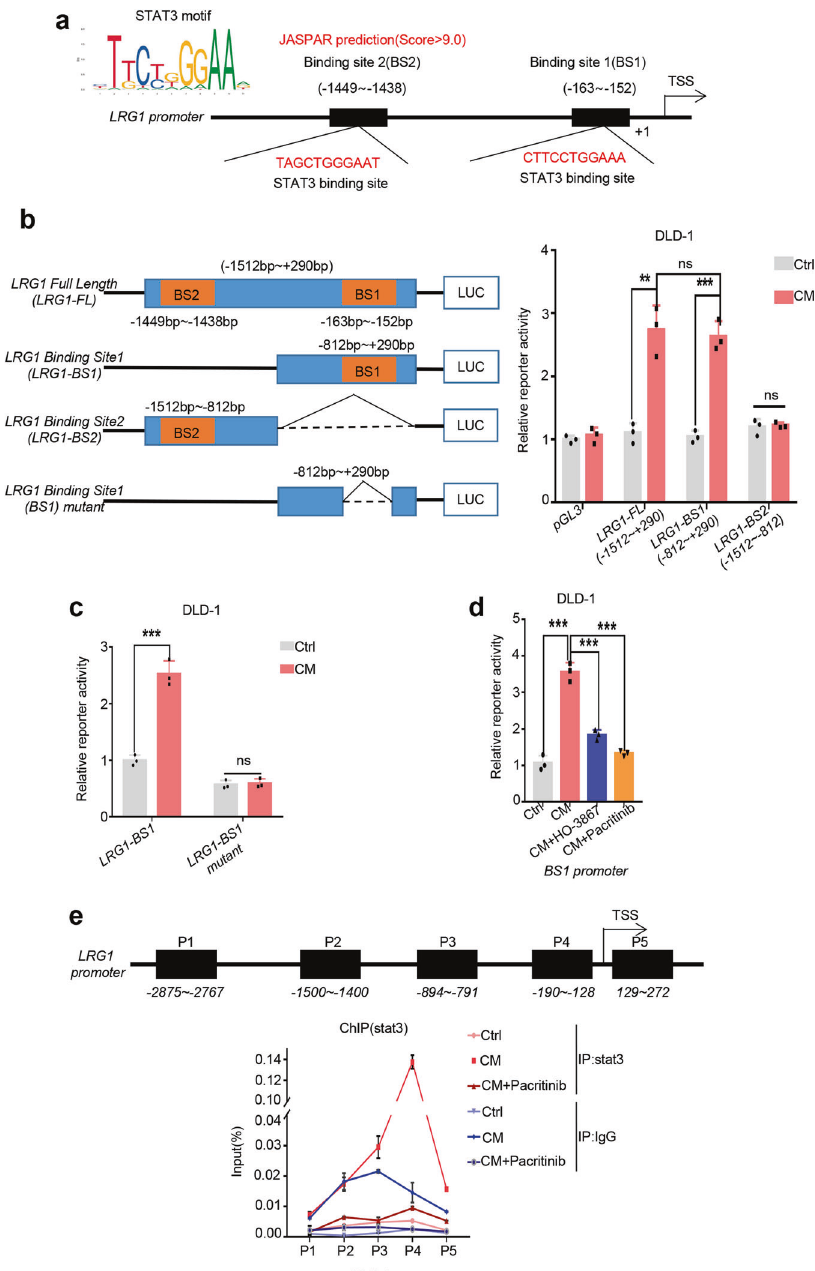
Fig. 5 STAT3 regulates LRG1 expression through direct binding to its promoter. a Schematic illustration of potential STAT3 binding sites located at LRG1 promoter region predicted by JASPAR. b Left: Scheme diagram depicting the design of LRG1 promoter regions in the luciferase reporter plasmids. Right: Activity of different fragments of LRG1 promoter in response to CM from CAF1 was determined by dual- luciferase assay. c Activity of LRG1 promoter with deletion of BS1 or not (named LRG1-BS1 and LRG1-BS1 mutant respectively) was tested by dual-luciferase assay. Graph showing relative activity of either promoter upon co-culture with CM from CAF1 or not. d DLD1 with LRG1 promoter containing BS1 was pre-treated with HO-3867 or pacritinib, followed by incubation with CM from CAF1 or not. Activity of LRG1 promoter was analyzed by dual-luciferase assay. e Top: Scheme depicting the regions where primers were designed for amplifying across LRG1 promoter. Bottom: DLD1 was pre-treated with or without pacritinib, followed by co-culture with CM from CAF1 or not. Quantitative ChIP-PCR assay was performed to detect the occupancy of stat3 protein at the different regions of the LRG1 promoter under indicated conditions. Error bars represent SD; n = 3. ** P < 0.01, *** P < 0.001, **** P < 0.0001; ns for no signi fi controversial. Several groups reported an inhibitory role of LRG1 on the migrative and invasive potential of different tumors including hepatocellular carcinoma (HCC) and esophageal squamous cell function. carcinoma (ESCC) [20, 21], whereas the underlying mechanisms Although several studies implicated that LRG1 might be one of have not been fully explored yet Our work demonstrated that LRG1 was highly expressed in metastatic CRC tissues. This